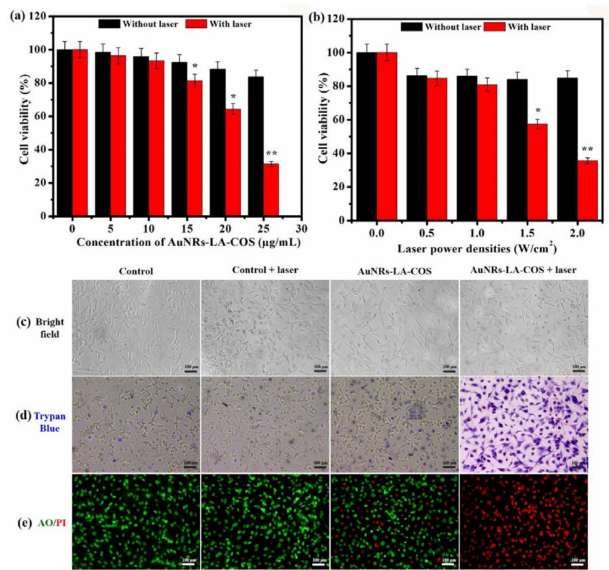
Figure 4. ( a ) Cell viability of MDA-MB-231 cells incubated with different concentration of AuNRs-LA-COS with or without 808 nm NIR laser irradiation at 2.0 W/cm 2 for 5 min. ( b ) Cell viability of MDA-MB-231 cells treated with AuNRs-LA-COS (25 µ g/mL) with 808 nm NIR laser irradiation at different power densities (0.5, 1.0, 1.5, and 2.0 W/cm 2 ) for 5 min. ( c ) Morphological observation in MDA-MB-231 cells incubated with or without AuNRs-LA-COS with or without 808 nm NIR laser irradiation at 2.0 W/cm 2 for 5 min (20 × magnification). ( d ) Optical images stained by trypan blue and the optical image of MDA-MB-231 cells incubated with or without AuNRs-LA-COS (25 µ g/mL), with or without 808 nm NIR laser irradiation at 2.0 W/cm 2 for 5 min (20 × magnification). ( e ) Fluorescence images stained by AO (live: green) and PI (dead: red). Merged fluorescence images of MDA-MB-231 cells treated with or without AuNRs-LA-COS (25 µ g/mL) with or without 808 nm NIR laser irradiation at 2.0 W/cm 2 for 5 min (20 × magnification).